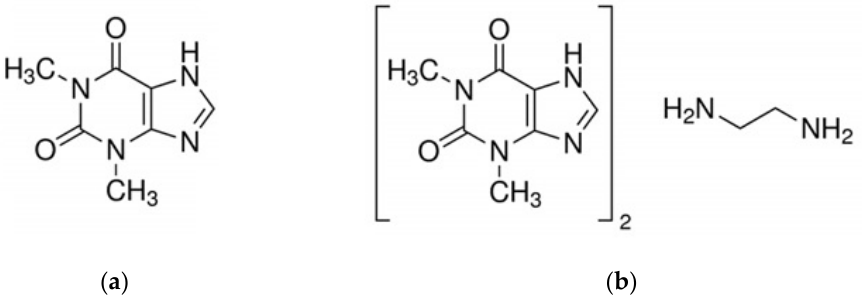
Figure 1. The chemical structure of ( a ) theophylline and ( b ) aminophylline